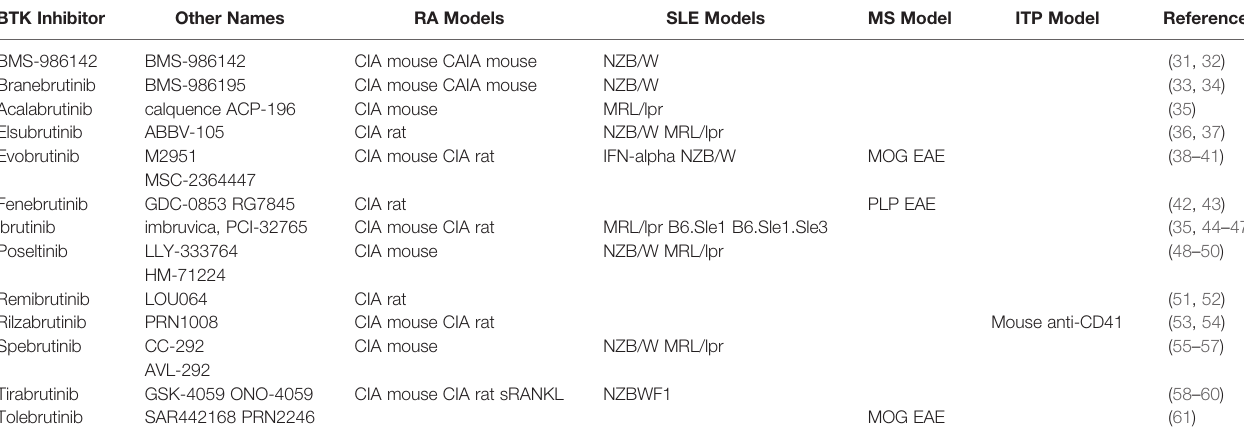
TABLE 2 | BTK inhibitors tested in preclinical animal disease models. BTK inhibitors tested in animal models of disease are listed if they have been reported. BTK